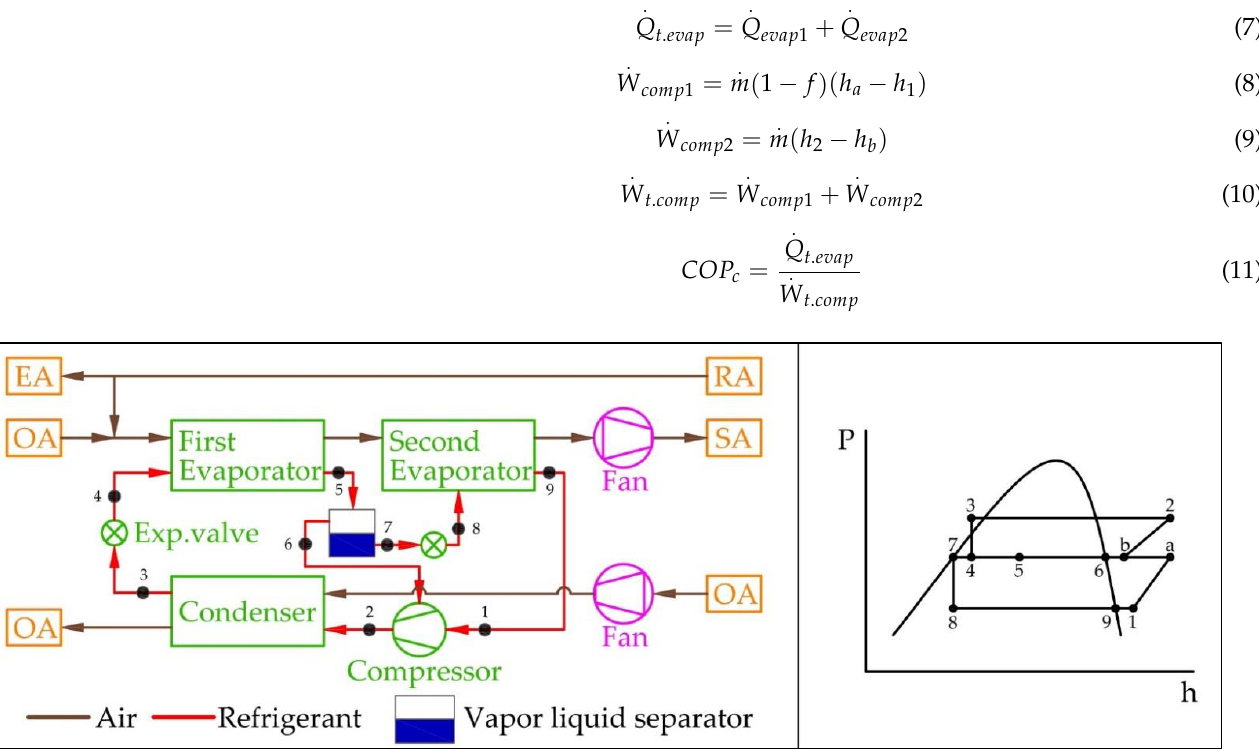
Figure 4. Two-evaporator heat pump system and P-h diagram.